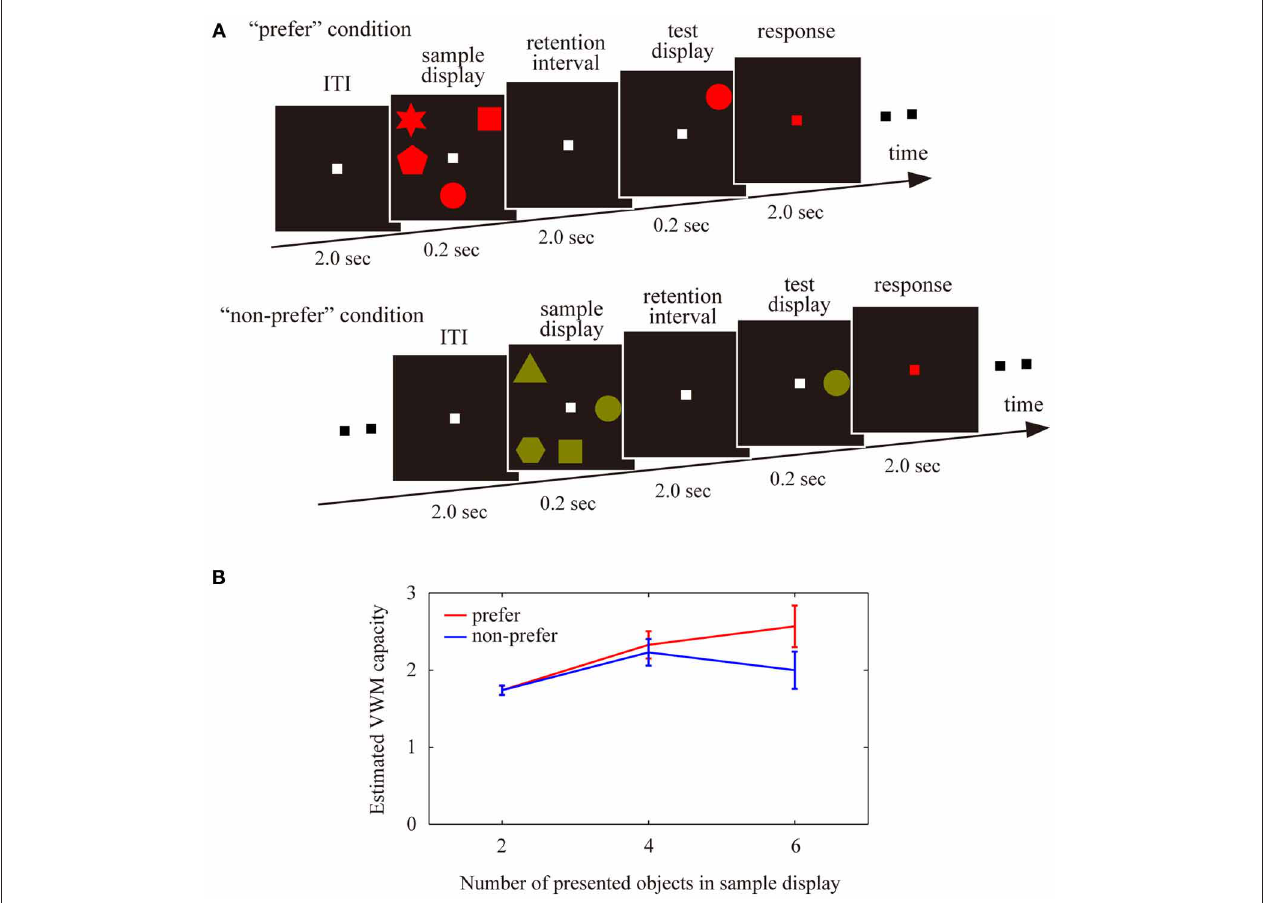
FIGURE 1 | (A) Schematic display of the trial sequences used for the visual working memory tasks, in the “preferred” and “non-preferred” conditions. Participants were asked to memorize either 2, 4, or 6 colored shapes, to maintain these shaped in working memory during the retention intervals, and then to judge whether a single probe